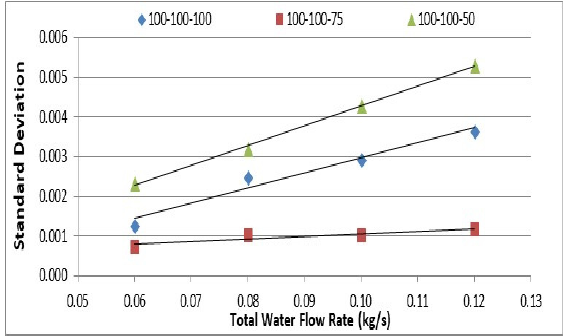
Fig. 15. The flow standard deviation between terminal units at 8 °C water supply temperature and valve opening: Valve 1=100%, Valve 2=100% and Valve